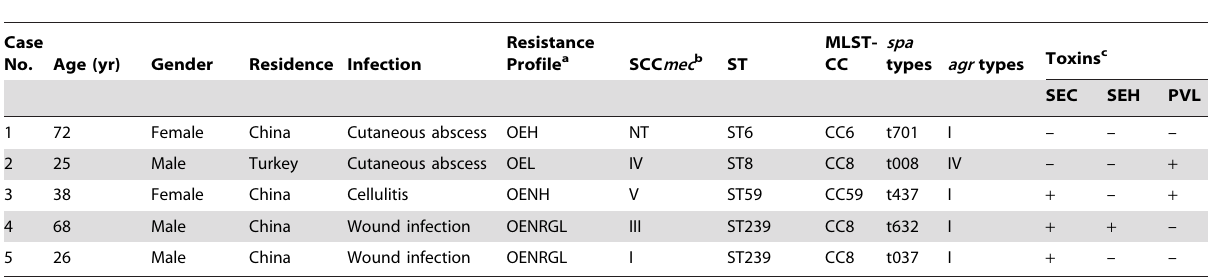
Table 3. Clinical and molecular features of 5 cases with CA-MRSA infections.